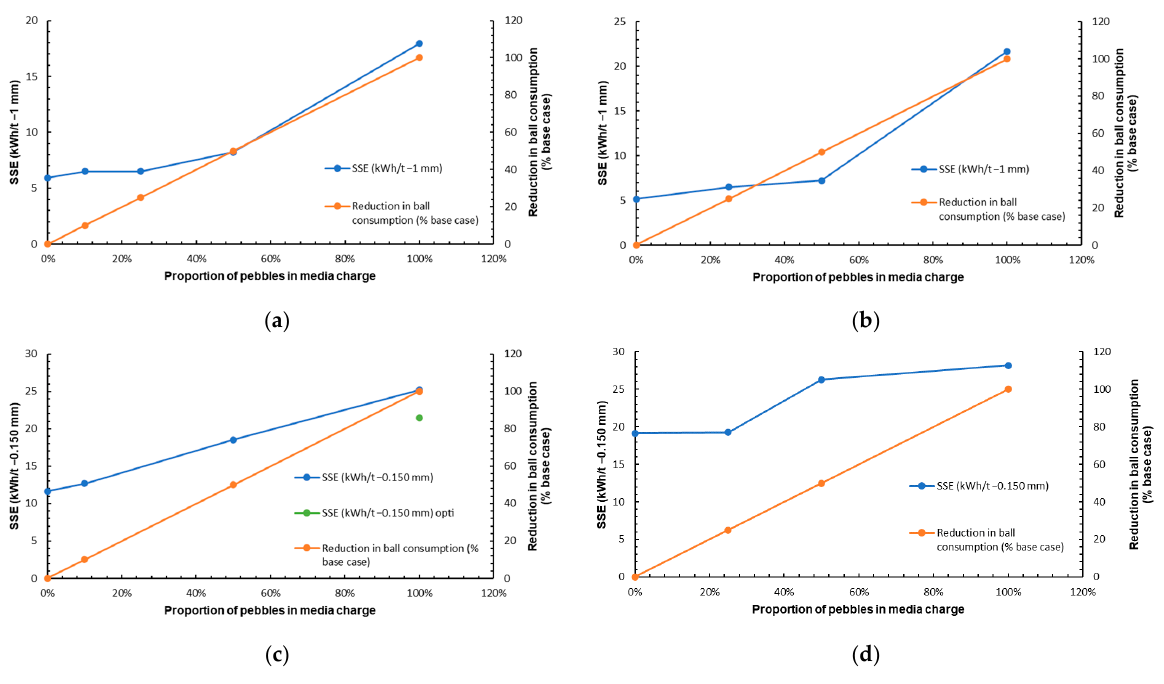
Figure 5. SSE s and reduction in ball consumption. ( a ) Primary grinding—Mill 1; ( b ) primary grinding—Mill 2; ( c ) secondary grinding—Mill 1; ( d ) secondary grinding—Mill 2.